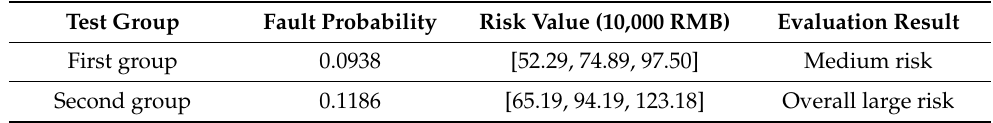
Table 12. Comparison of the evaluation results of different fault probabilities. Test